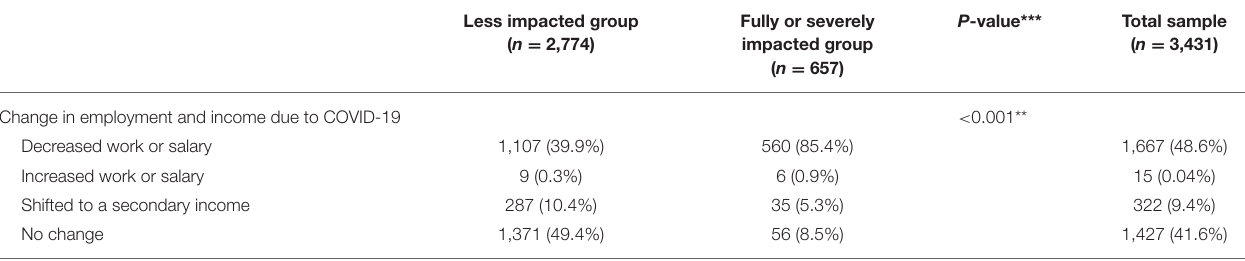
TABLE 2 | Change in source of employment and income due to Covid-19.